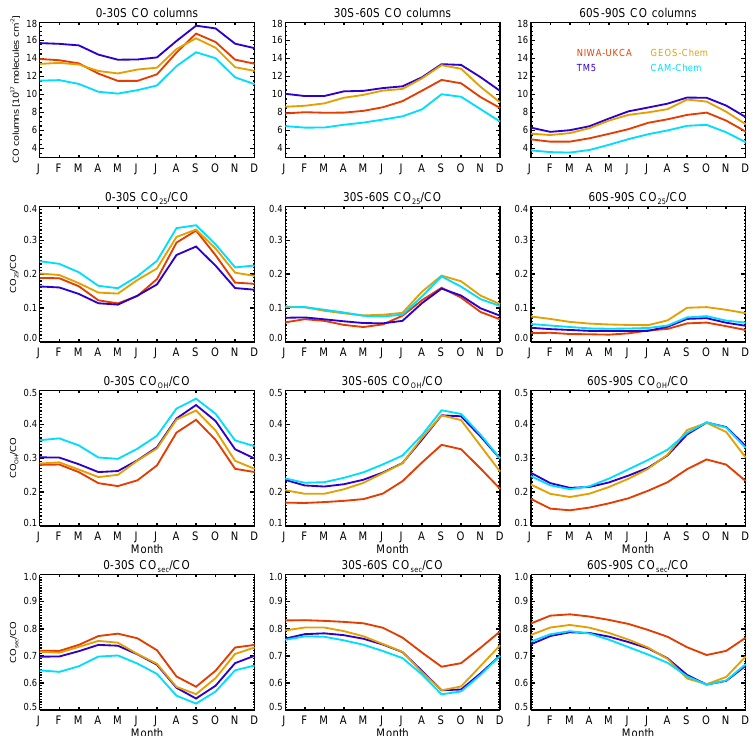
Figure 13. Monthly mean CO columns (top) and the ratio of CO 25 to CO, CO OH to CO, and CO sec to CO columns averaged over three SH regions (0–30, 30–60, and 60–90 ◦ S). Data are for the year